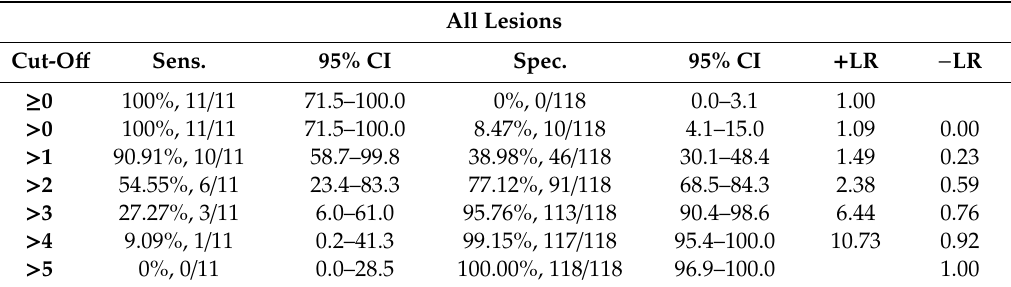
Table 2. Diagnostic parameters and cut-o ff values of the score for reader R1.